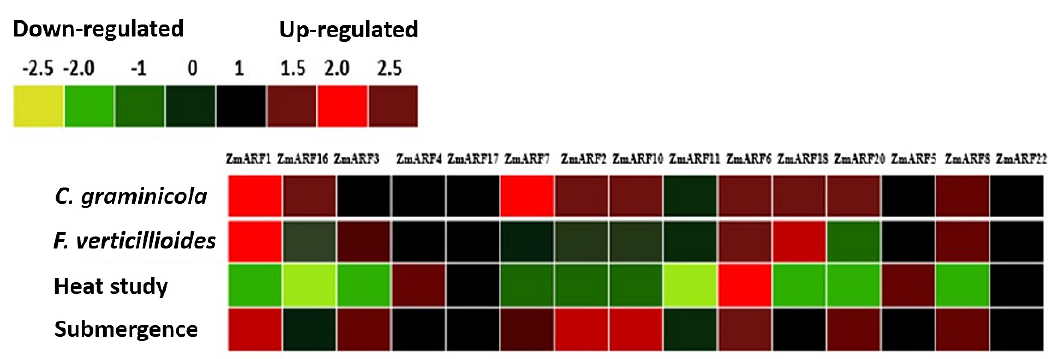
Figure 4a. Heatmap analysis of ZmARF genes in response to environmental